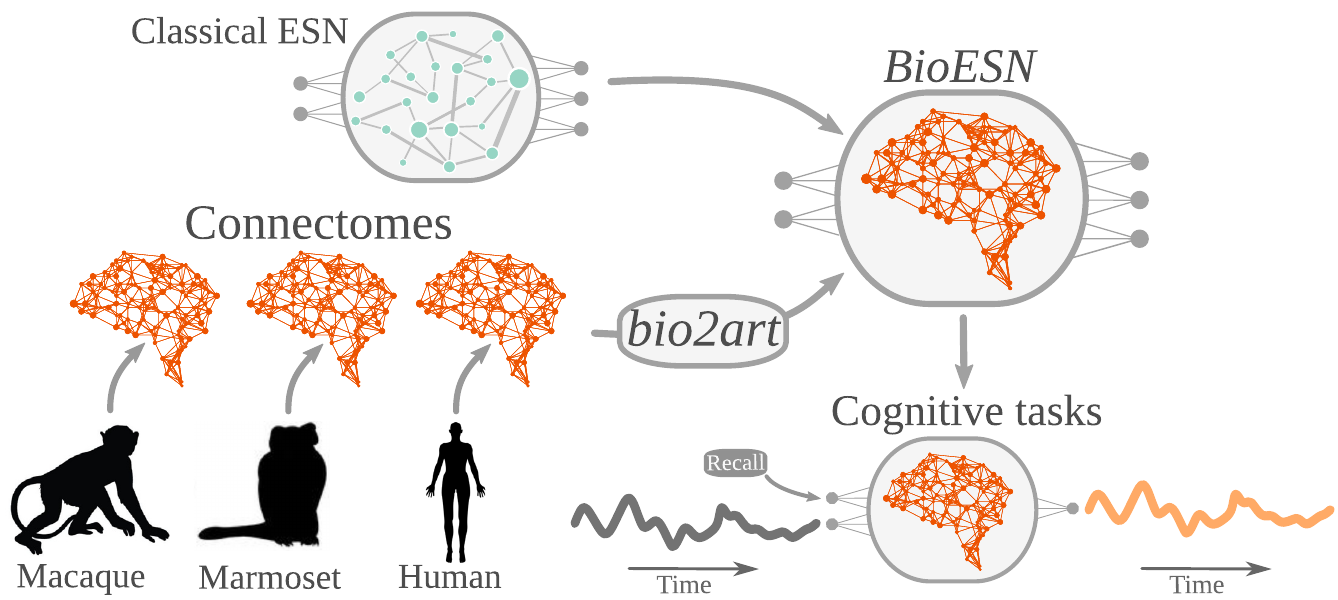
Fig 1. General approach scheme. For each of the three species we generated a Bio- Echo State Network ( BioESN ) by integrating the real connectivity pattern as reservoir of an Echo State Network (ESN). Thus, in contrast to the classical ESN with randomly connected reservoir, BioESNs have connectomes based on connectivity coming from the empirical connectomes. We also propose a framework for mapping biological to artificial networks, bio2art , which allows to optionally scale up the empirical connectomes to augment the model capacity. The resulting BioESNs are then tested on cognitive tasks (see Methods for details on the tasks).